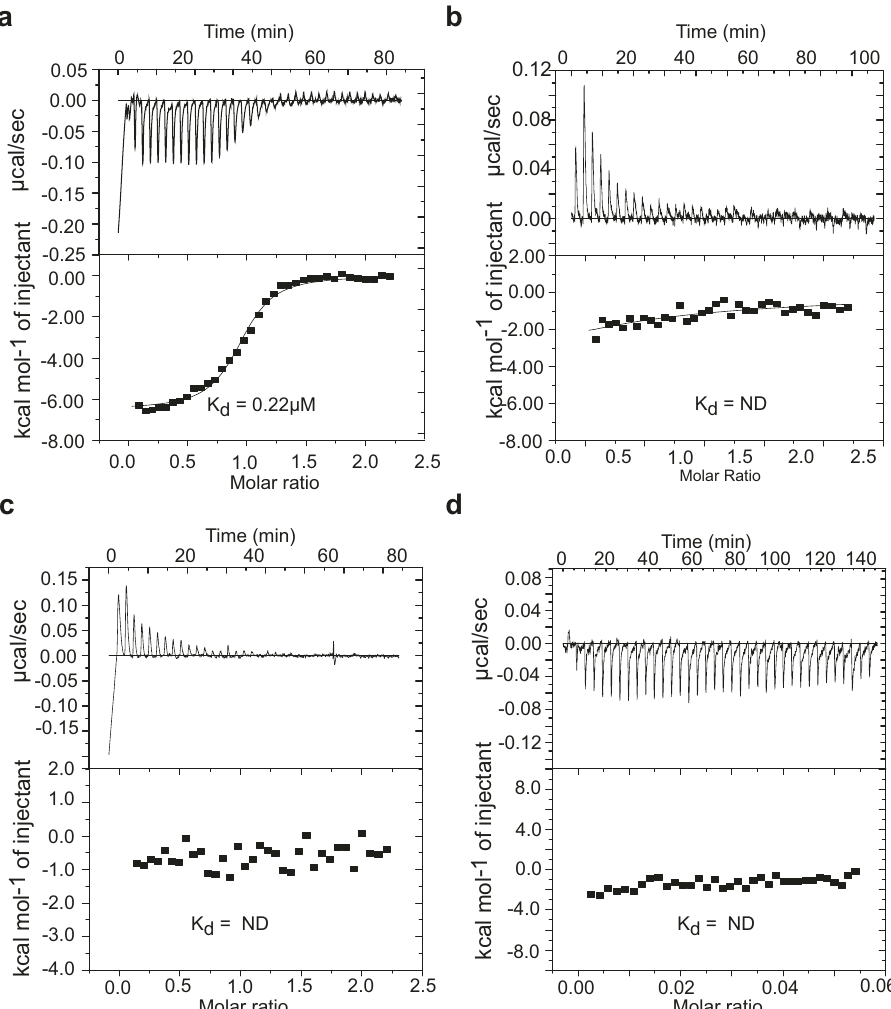
Fig. 6 Isothermal titration calorimetry of nMazE6-operator DNA binding. a Isothermogram of the titration of operator DNA with nMazE6 at 30 °C. An exothermic interaction was observed with a K d of 0.22 μ M. b Isothermogram of mutated operator DNA at 30 °C. c , d Isothermograms of the titration of scrambled DNA and non-cognate ( mazEF9 ) operator DNA with nMazE6 at 30 °C respectively. The top portion of each panel shows the raw titration data, and the bottom portion of each panel shows the integrated heats fi t to single-binding site isotherms after subtracting the heats of dilution (endothermic in this case) (Refer Materials and method for details). The calculated (K d ) values are shown in each panel. The concentration of the titrate (DNA) was 10 μ M, while that of the titrant (nMazE6) was 100 μ M. (ND- Not determined). Source data are provided in the Supplementary Data